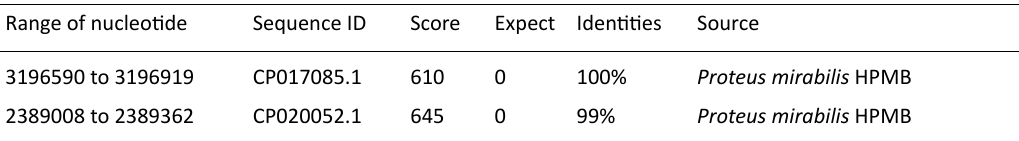
table 2. Identity of hpmB gene sequence in Range of nucleotide